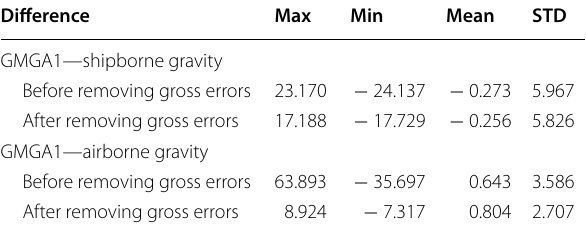
Table 8 Accuracy evaluation using shipborne and airborne gravity observations (unit: mGal) Difference Max Min Mean STD